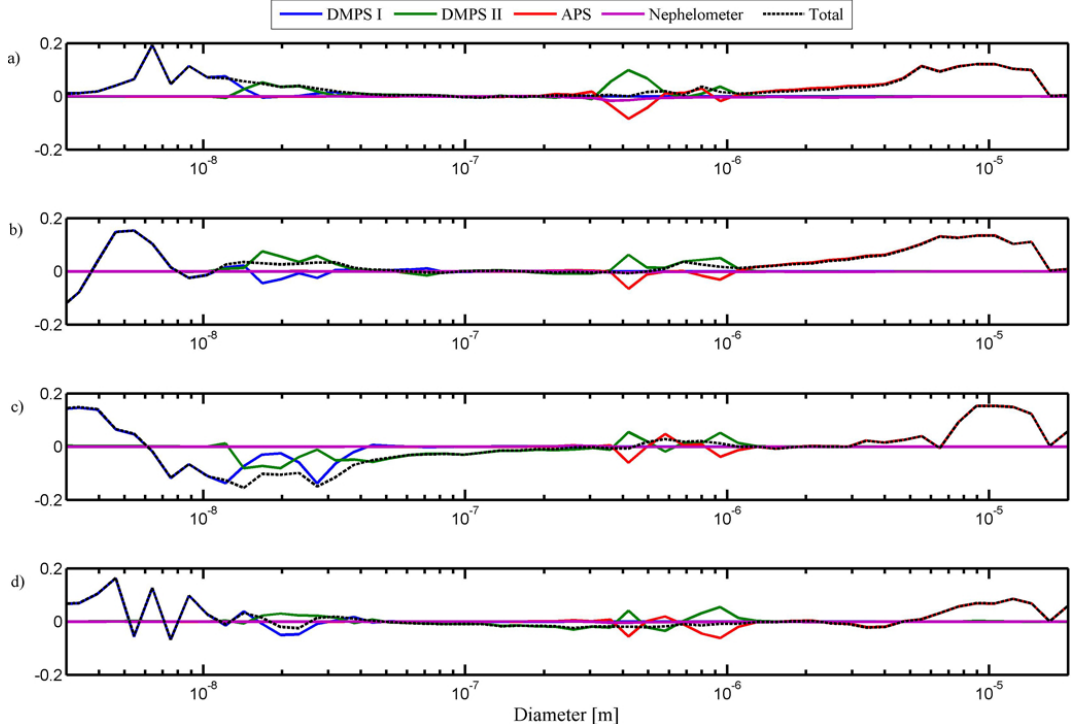
Fig. 8. The average relative increment for DMPS I (blue), DMPS II (green), APS (red), nephelometer (purple) as well as the average total relative increment (black, dashed) for time windows (a) 00:00–09:00, (b) 09:00–17:00, (c) 17:00–19:00 and (d) 19:00–23:00 on 7 May